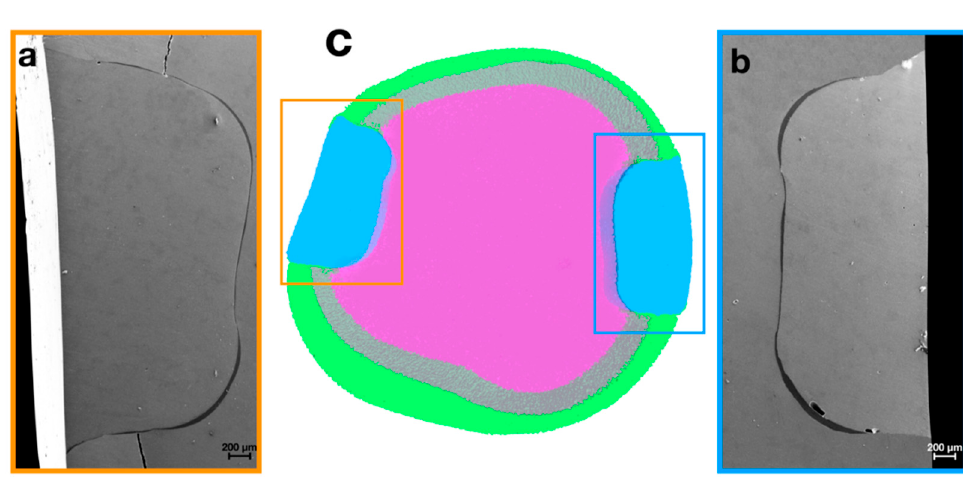
Figure 4. SEM observations of restorations gaps ( a , b ) and µ -CT colored 3D reconstruction of a BG representative sample ( c ). Green—enamel; pink—dentin (in transparency the superposition of the dentin with the enamel); blue—restorations.